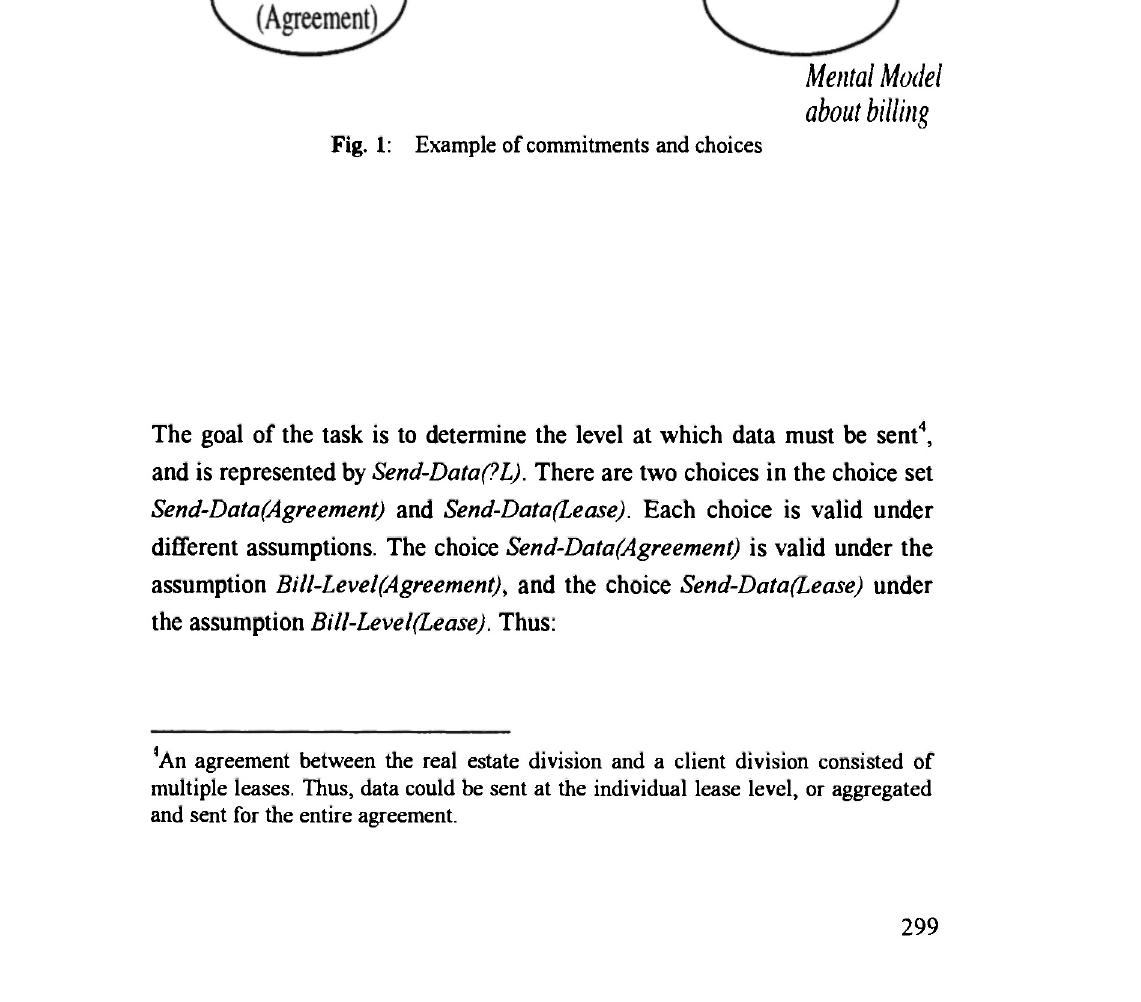
Fig. 1: Example of commitments and